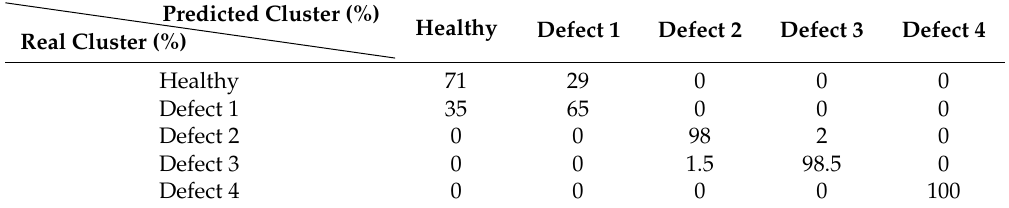
Table 2. Matching matrix of the clustering results plotted in Figure